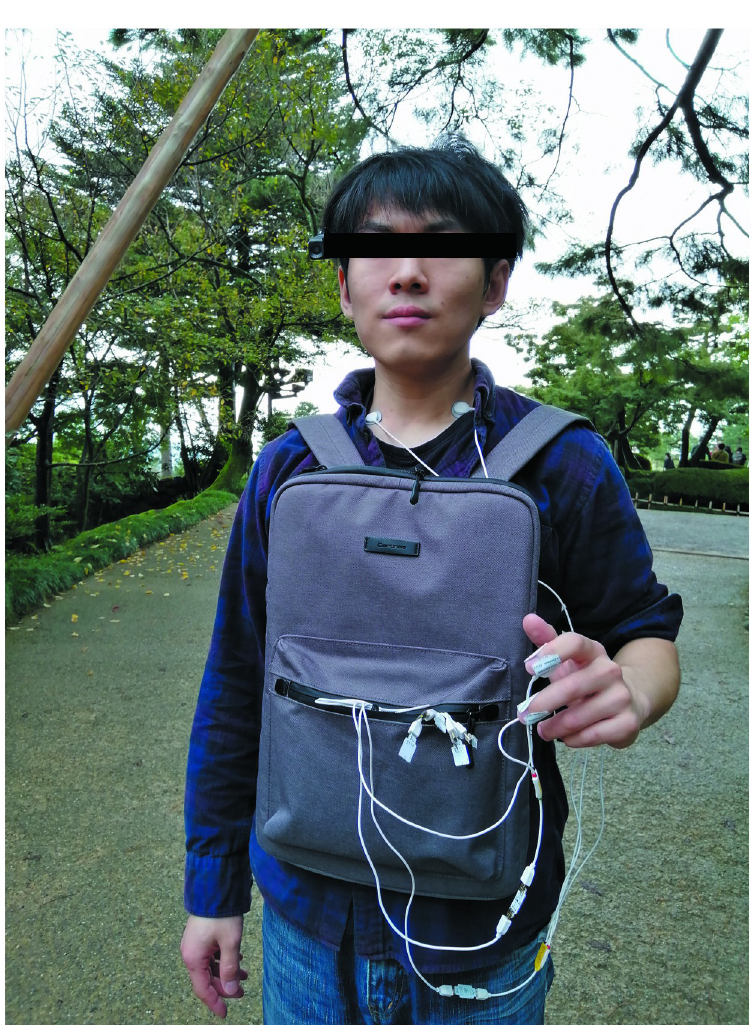
Fig 4. The participants wore a physiological signal feedback device (BITalino (r)evolution Plugged kit), carried a GPS device (Nav-u NV-U73T, Sony) and a laptop computer as they walked through the selected space route at a natural pace and constant speed. They could turn their heads to look at their surroundings. The computer automatically recorded the EDA, ECG, and EMG. The position where the electrodes of the physiological signal feedback instrument were pasted on the body: the two EDA electrodes were fixed on the first phalanx of the index and middle fingers; the ECG electrodes were fixed at the carotid arteries on both sides of the neck; the EMG electrodes were fixed on the inner side of the forearm of the